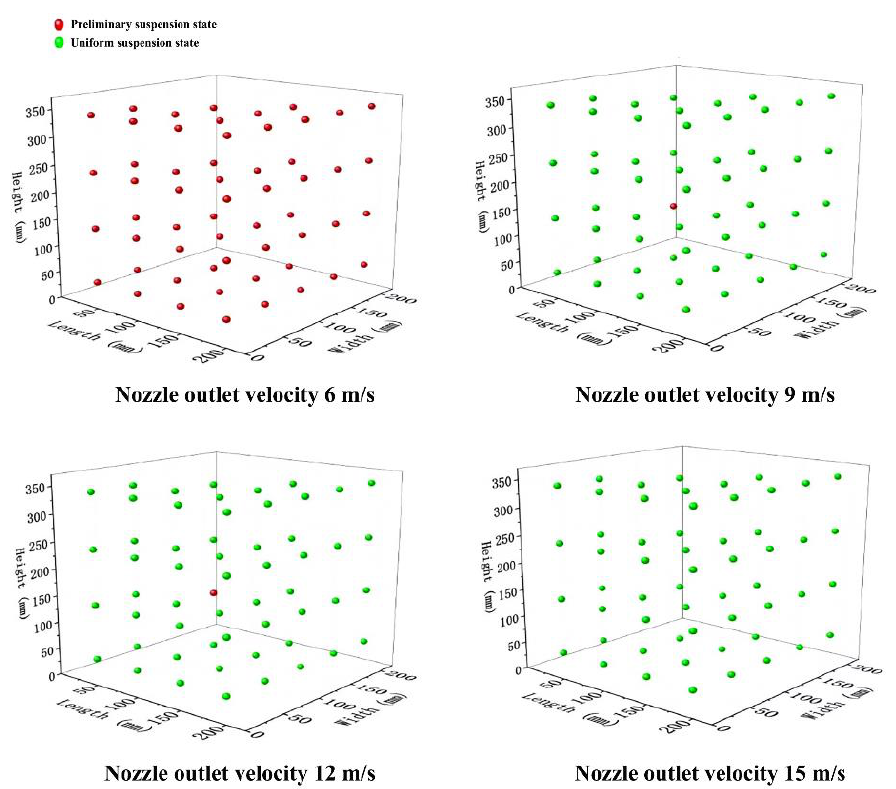
Figure 7. Suspension state of each sampling point under different jet velocity.